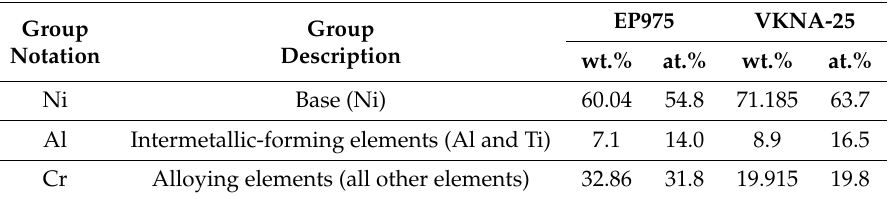
Table 2. Three groups of elements: constituents of groups, mass and atomic percentages of elements of VKNA-25 and EP975